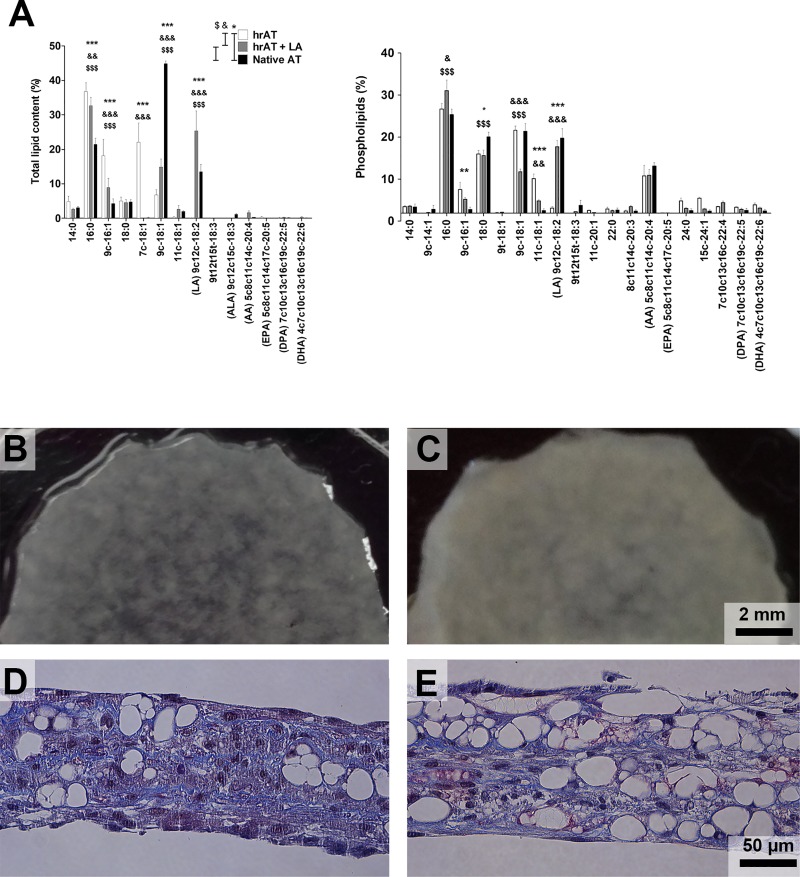
Effect of LA supplementation on lipid accumulation in engineered adipose tissues.(A) Analysis of the total lipid and phospholipid profiles by gas chromatography of human reconstructed adipose tissues (hrAT) supplemented with 150 μM LA during 25 days compared to native fat and to the control tissues cultured with the vehicle only (ethanol). Fatty acids with a value lower than 1% for each condition in total lipid content are not shown (n = 5). (B-C) Macroscopic images of reconstructed adipose tissues cultured in (B) control culture media or (C) in media supplemented with LA. (D-E) Masson’s trichrome staining of transversal sections of reconstructed adipose tissues cultured in (D) control culture medium or in (E) LA-supplemented medium. * = between hrAT and native AT; & = between hrAT and hrAT+ LA; $ = between hrAT + LA and native AT, * = p < 0.05; ** = p < 0.01; *** = p < 0.001.